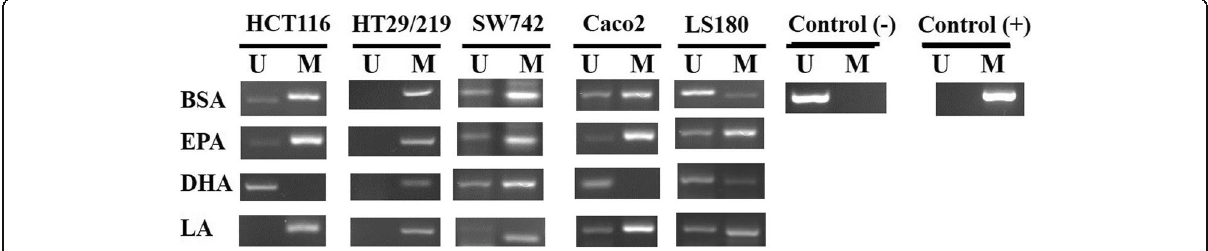
Fig. 1 Representative MSP for promoter methylation analysis of EGFL7 (miR-126) in five CRC cell lines exposed to EPA, DHA, and LA. U, unmethylated genes; M, methylated genes; EPA, eicosapentaenoic acid; LA, linoleic acid; DHA, docosahexaenoic acid; BSA, bovine serum